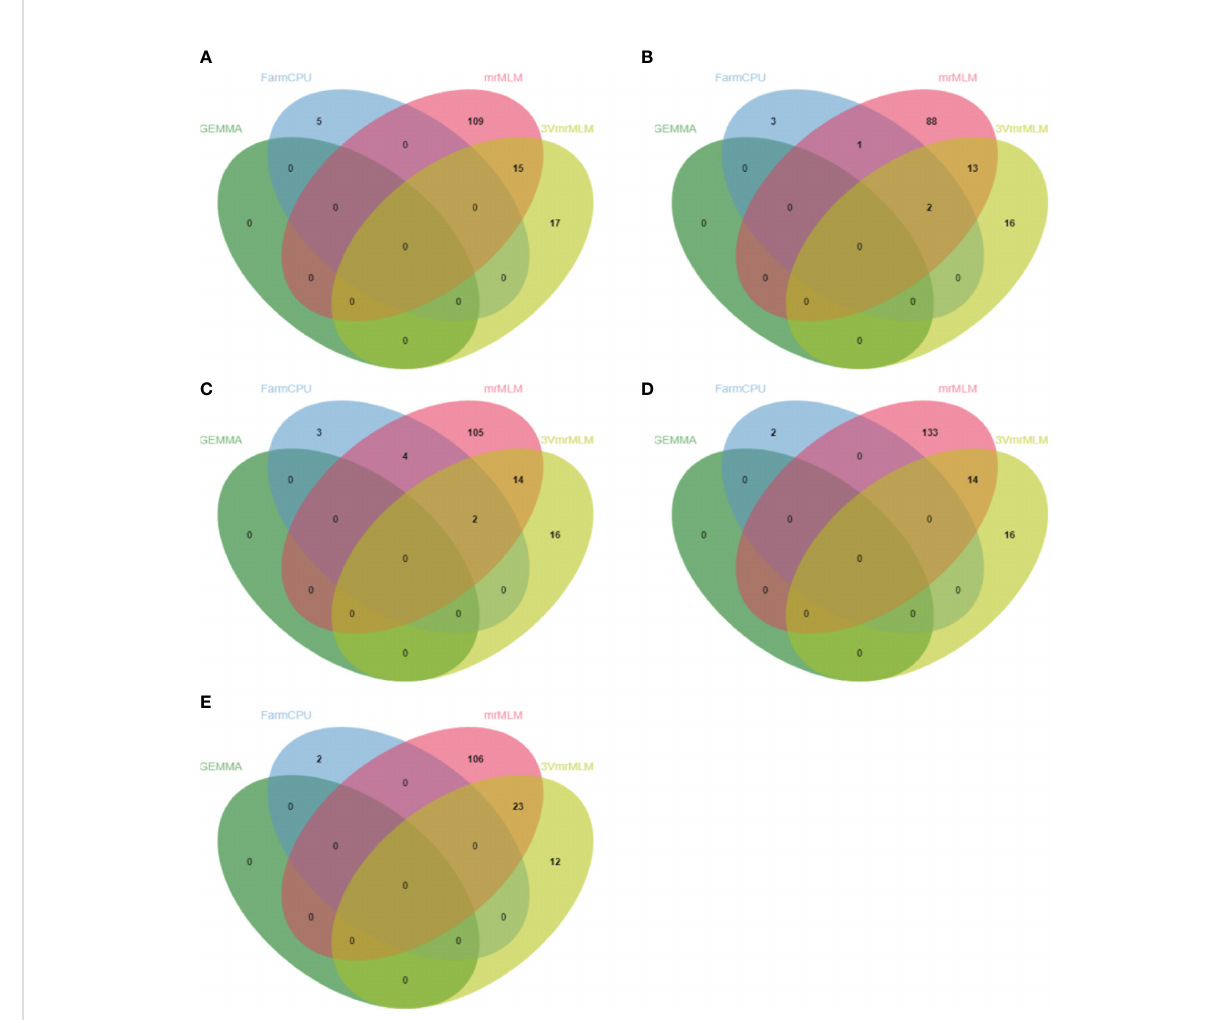
FIGURE 4 Venn diagrams of unique QTNs detected by different GWAS methods from Val (A) , Leu (B) , Ile (C) , Arg (D) , and Trp (E) datasets. mrMLM represents mrMLM series methods including mrMLM, FASTmrEMMA, pLARmEB, pKWmEB, ISIS EM-BLASSO, and